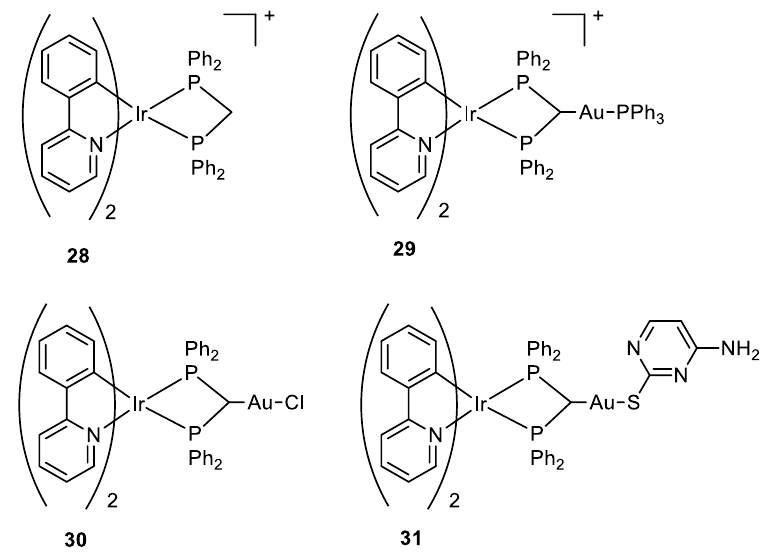
Figure 15. Molecular structure of compounds 28 – 31 . Luengo and co-workers published a paper on Au(I)-Re(I) heterometallic complexes